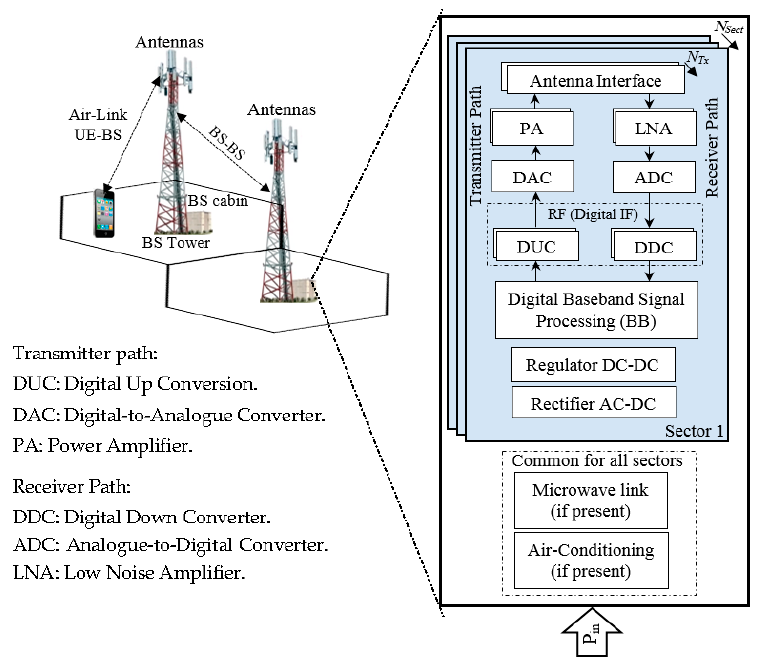
Figure 3. Block diagram of macro-BS hardware elements [21–23].